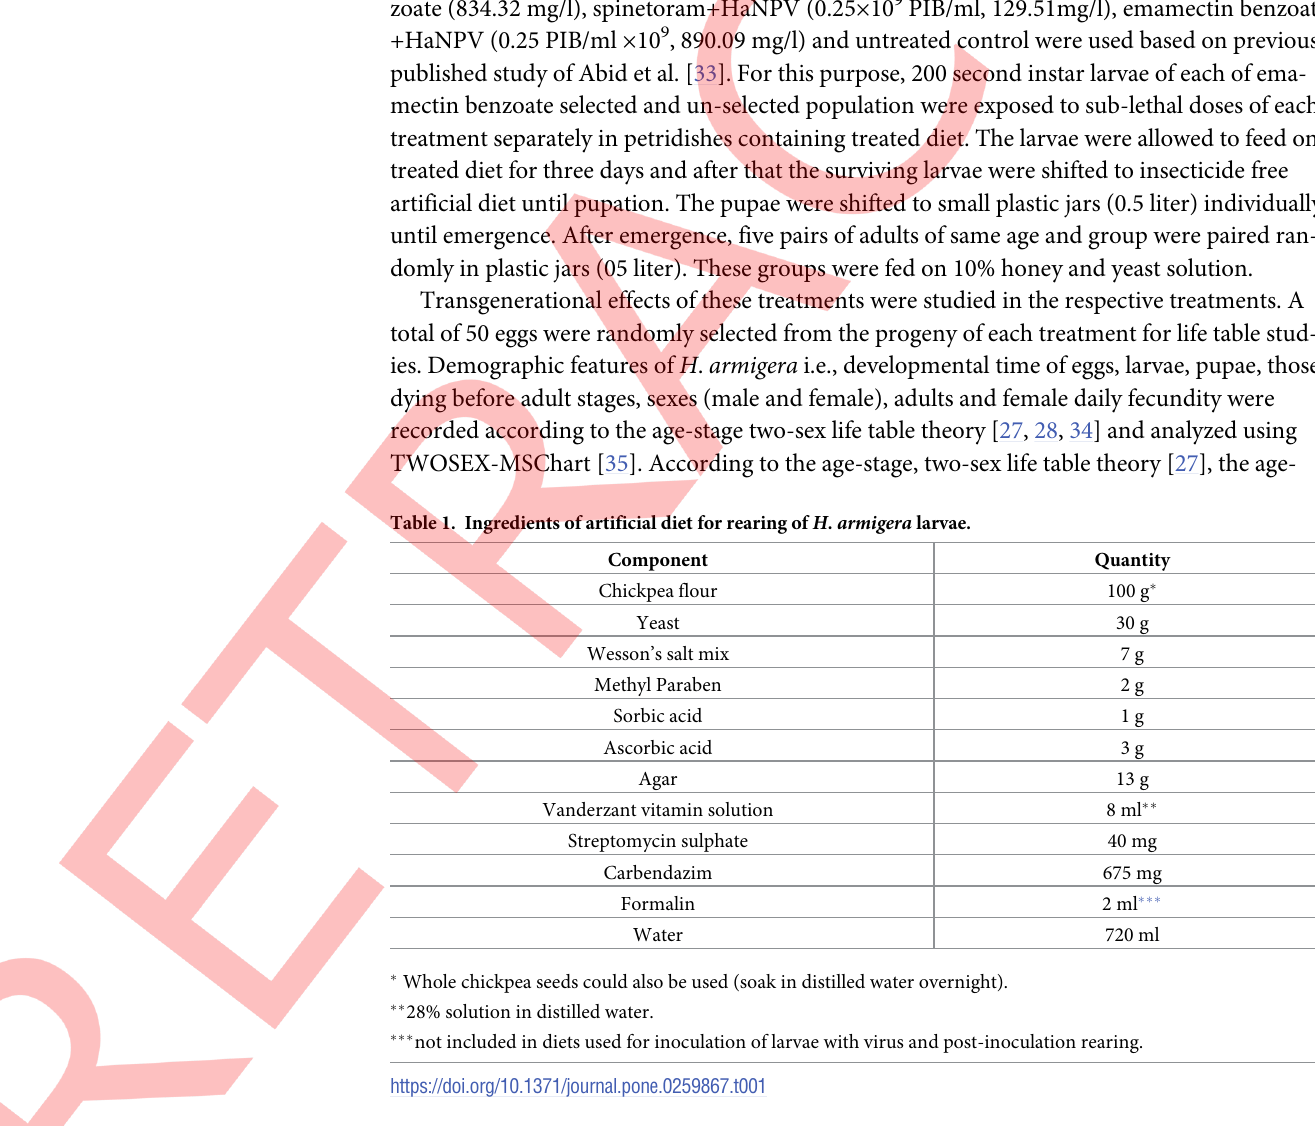
Table 1. Adults of H . armigera were reared on honey and yeast solution. The treatments include spinetoram, emamectin benzoate and Helicoverpa armigera Nucleopolyhedrosis Virus (HaNPV) used alone and in combinations. Commercial formulations of spinetoram (Radi- ant 1 120 SC Arysta LifeScience Pakistan) and emamectin benzoate (Proclaim 1 019 EC, Syn- genta Pakistan) were purchased from local market. However, HaNPV was used from laboratory maintained culture. To test a hypothesis if a single factor created three subpopulations having fitness cost com- pared with unselected and laboratory standard populations fecundity, developmental and sur- vival rate; selected and unselected lines in the presence or absence of selection agent was studied as described previously [26, 32]. Sub-lethal treatments and trans-generational effect The sub-lethal doses (LC ) of HaNPV (0.32 × 10 9 ) spinetoram (192.39 mg/l), emamectin ben- 25 zoate (834.32 mg/l), spinetoram+HaNPV (0.25 × 10 9 PIB/ml, 129.51mg/l), emamectin benzoate